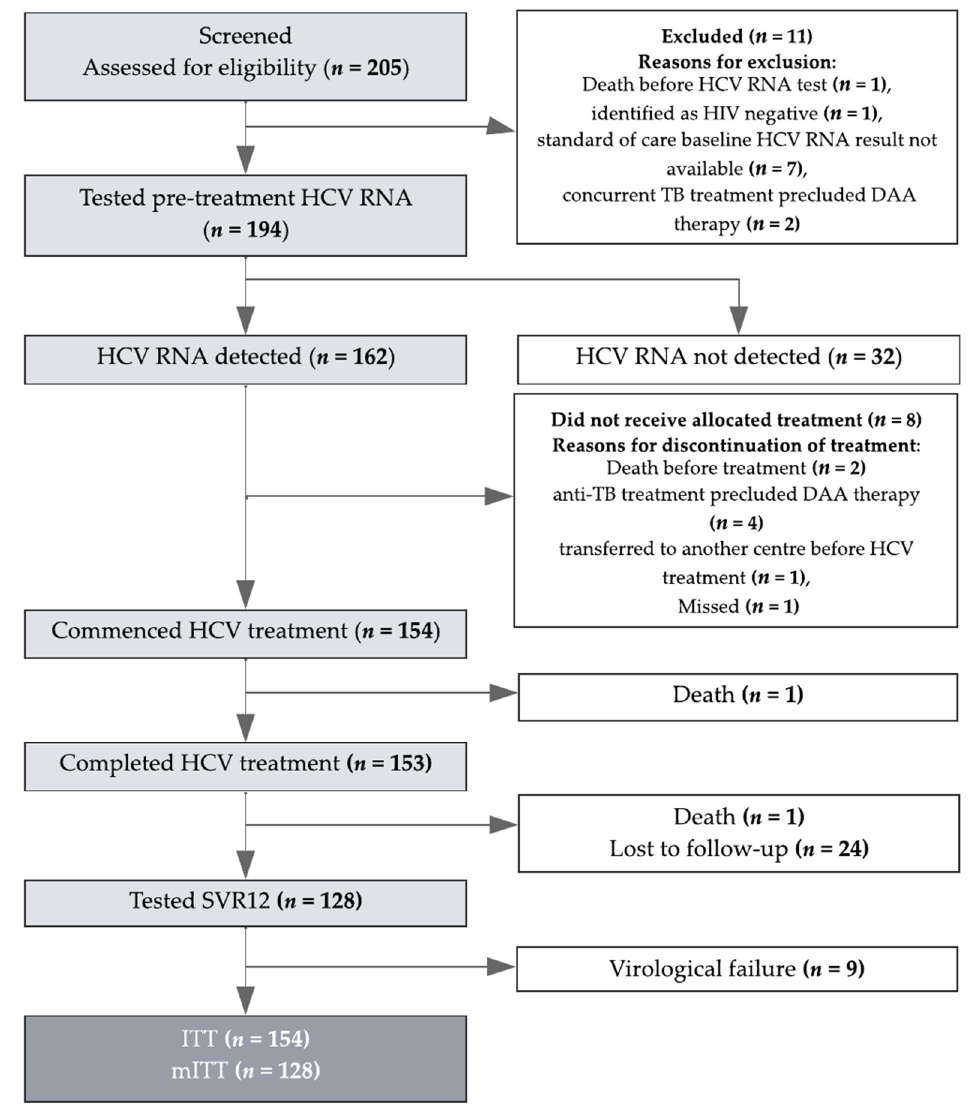
Figure 1. Patient Disposition. HCV: hepatitis C virus; ITT: intention-to-treat; mITT: modified intention-to-treat. The number of participants screened (194/205; 95%), with detectable HCV RNA (162/194; 84%) and who commenced treatment (154/162; 95%) is depicted. Of the 11 patients who were excluded at screening, 7/11 (64%) did not have a standard of care HCV RNA result available at the time of treatment assessment, 2/11 (18%) had concurrent treatment, 1/11 (9%) died prior to HCV RNA testing, and 1/11 (9%) was identified as HIV-negative. Among those 8/162 (5%) who did not commence treatment, 2/8 (25%) died before treatment, 4/8 (50%) were receiving anti-TB treatment precluding DAA therapy, 1 was transferred to another centre before treatment and 1 missed the treatment. One death occurred during treatment due to hepatic decompensation. This participant had underlying cirrhosis and died 15 weeks after commencing therapy.